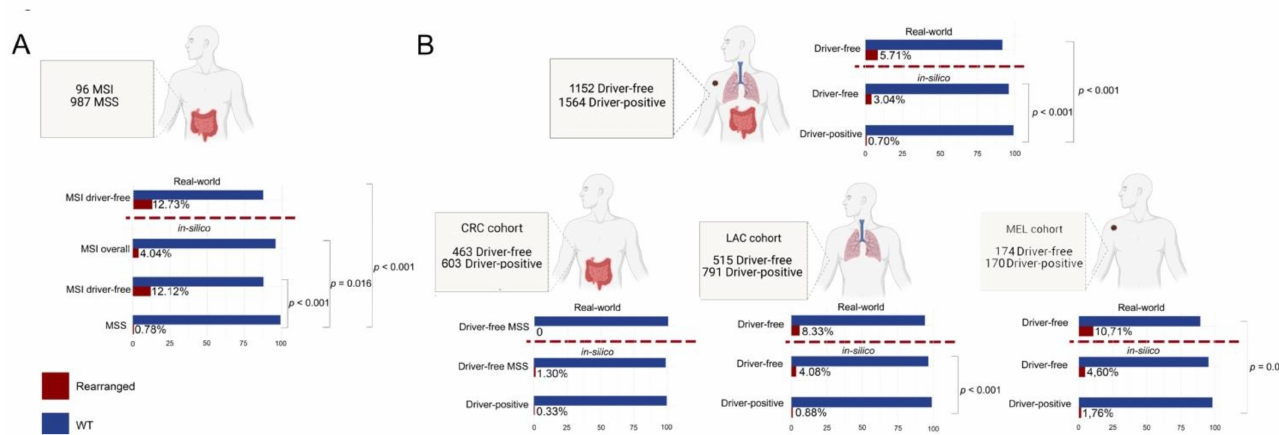
Figure 3. Comparison of the distribution of fusion gene detection rates across “real-world” and in silico cohorts. ( A ) Graph- ical representation of the in silico microsatellite instable (MSI) cohort and the description of fusion prevalence in both the in silico and the “real-world” MSI cohorts. ( B ) Graphical representation of the cohort as a whole (top) and of the subgroups of cases according to the distinct histology and comparison between “real-world” and in silico data. The percentage of samples harbouring a fusion and significant p -values of the contingency tables are shown in a horizontal bar plot. Fusion positive cases are color-coded according to the legend (bottom-left). Dashed red lines separate the study cohort (“real-world”) from the in silico Memorial Sloane Kettering Cancer Centre (MSKCC)